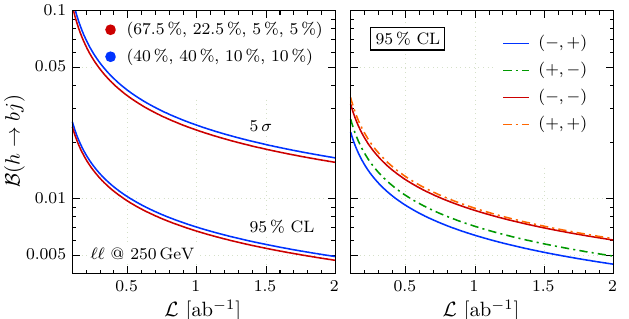
Figure 3. Left : expected 95 % CL exclusion and 5 (cid:27) discovery reaches on charged lepton channel at p s = 250 GeV as a function of the total integrated luminosity for the two polarisation scenarios described in the text. Right : expected exclusion reaches for the four possible polarisation con(cid:12)gurations individually. Both plots assume (cid:15) syst = 1